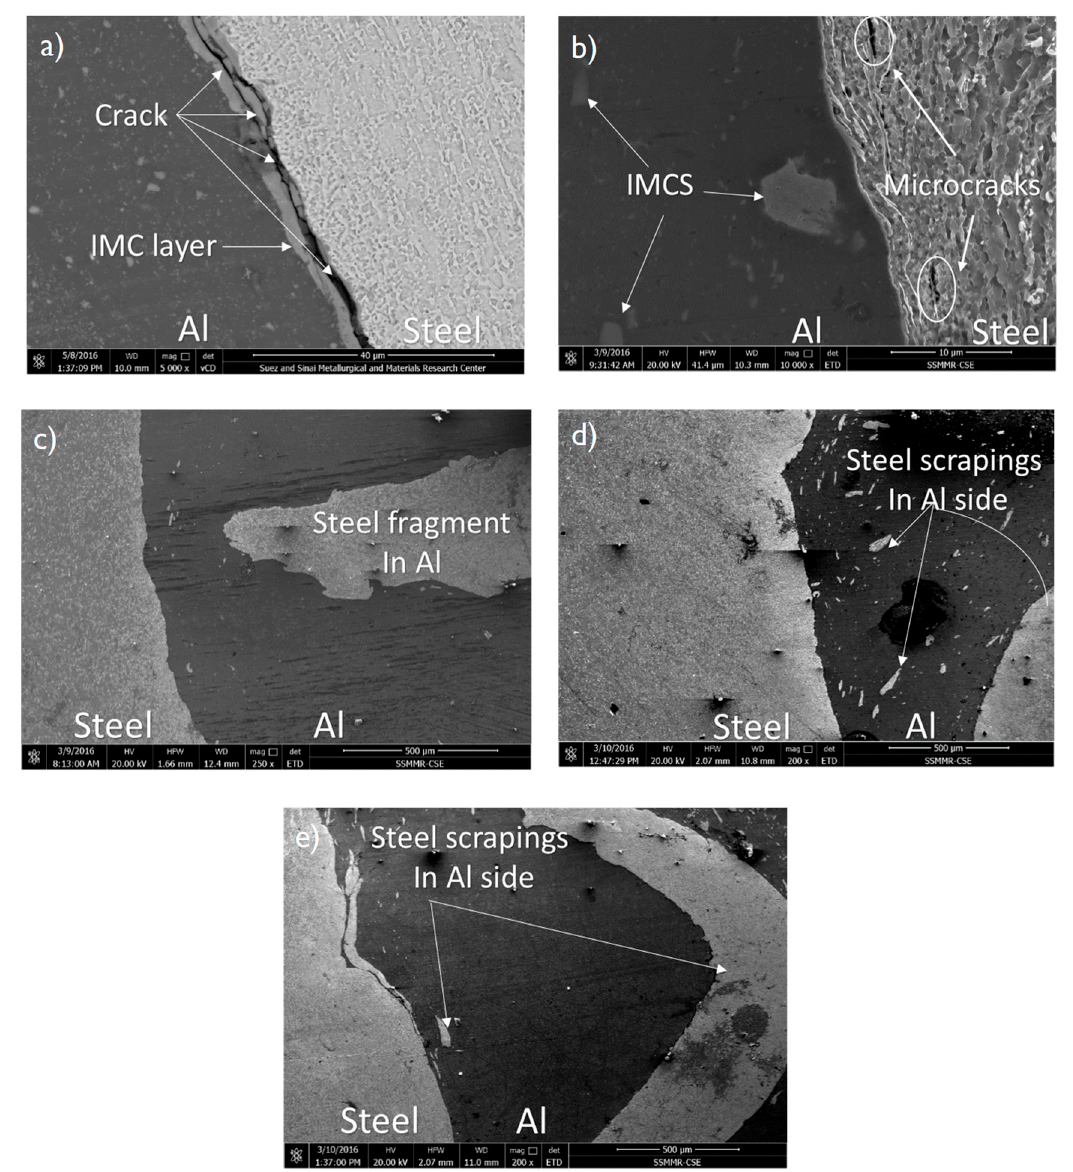
Figure 8. SEM micrographs at the Al–steel interfaces obtained from the FSWed aluminum alloy AA2024 and mild steel 1018 joints produced at different welding conditions: ( a ) 250 rpm and 25 mm/min; ( b ) 250 rpm and 50 mm/min; ( c ) 250 rpm and 75 mm/min; ( d ) 200 rpm and 50 mm/min; and ( e ) 300 rpm and 50 mm/min. Intermetallics (IMCs) positions are indicated on the micrographs.